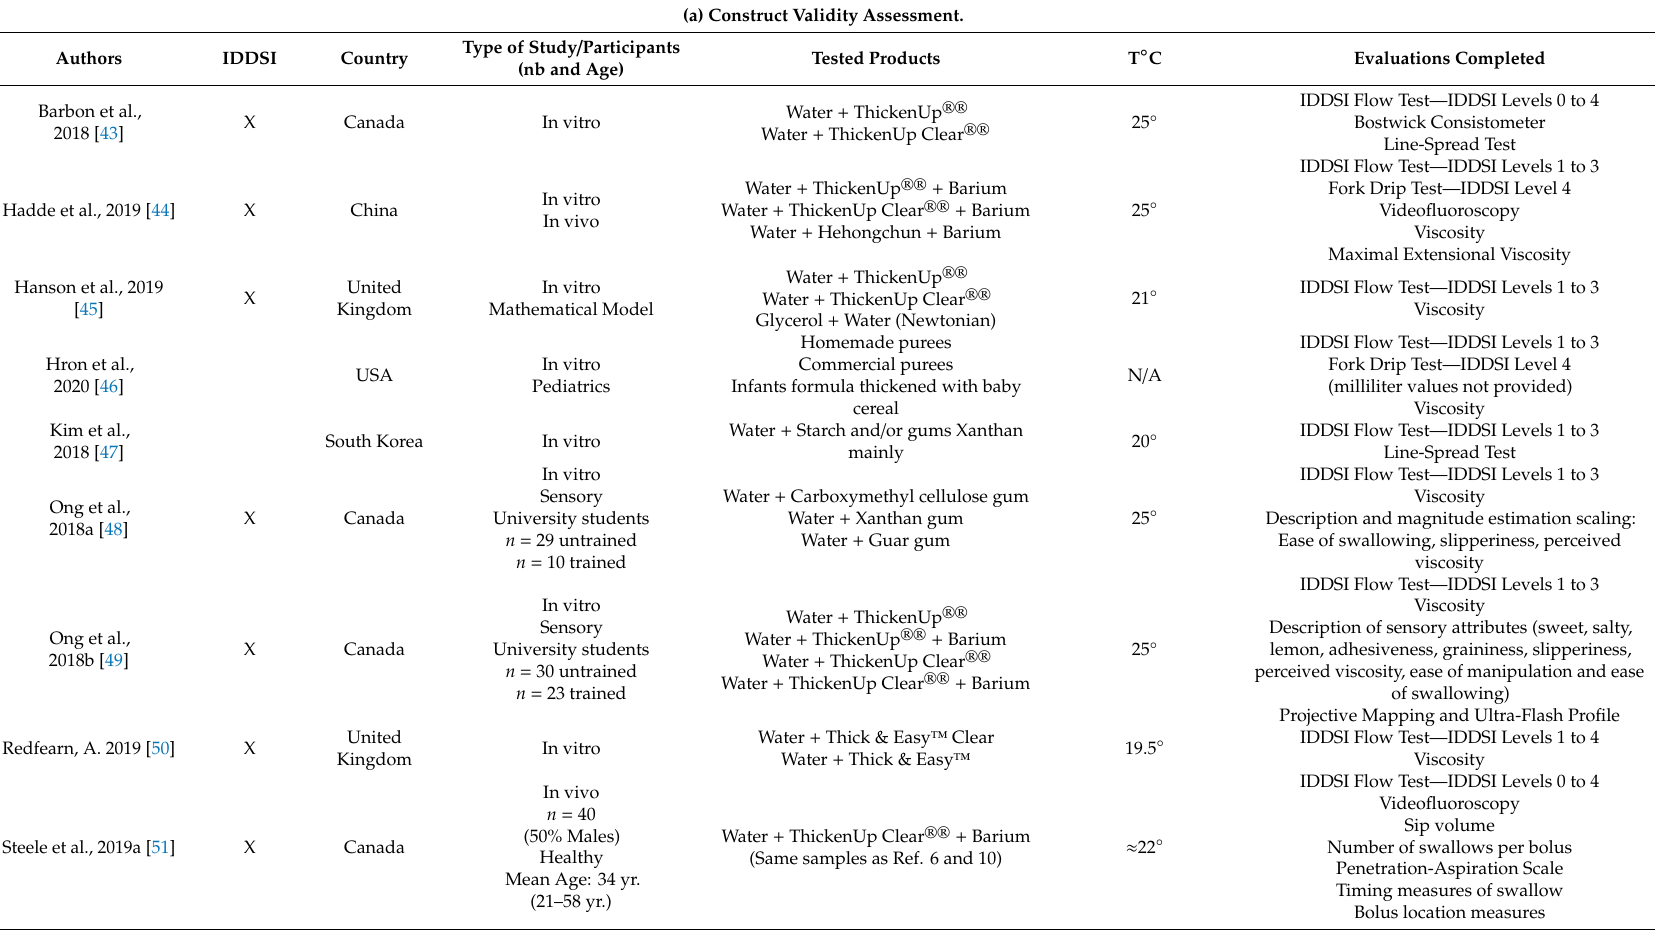
Table 3. Contextual characteristics of references documenting construct validity and reliability of IDDSI assessment tools. (a) Construct Validity